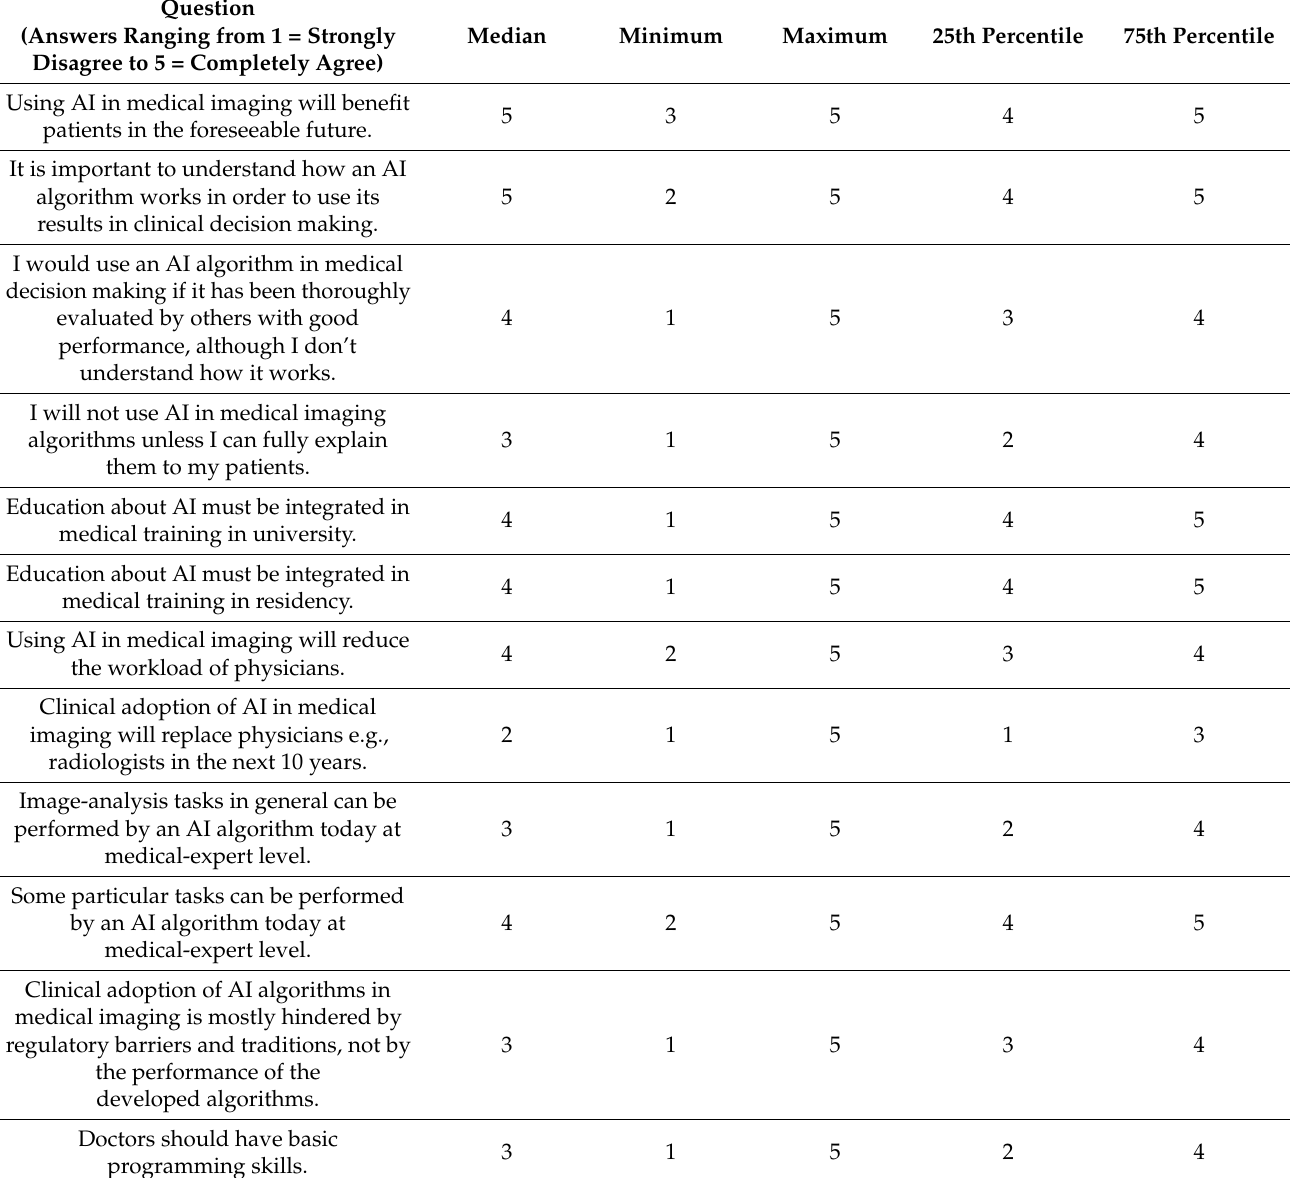
Table 2. Questionnaire on the participants’ opinions on artificial intelligence in medical imaging and its clinical adoption. Results of the pre-course survey were given on a five-point Likert scale ranging from 1 = strong disagreement to 5 = complete